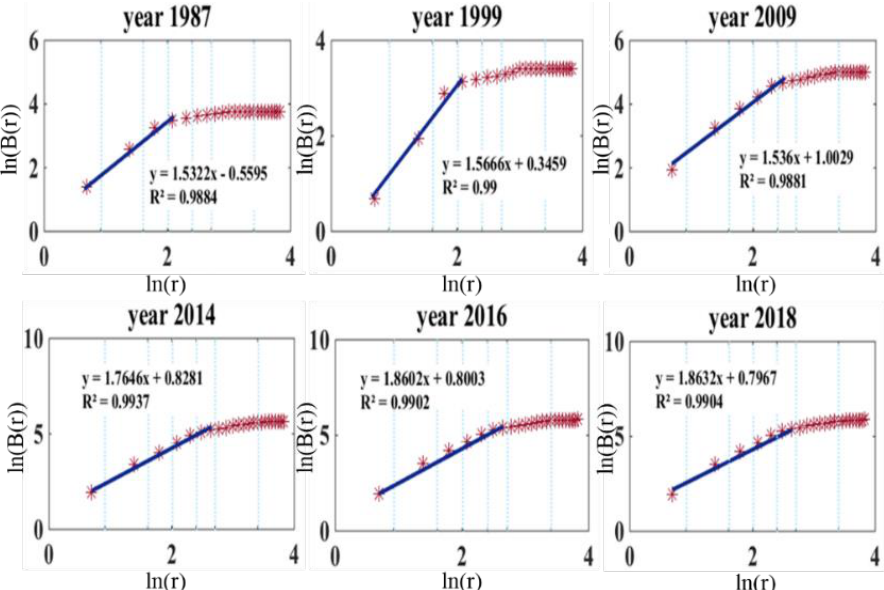
Figure 9. Fitting plots of branch dimension.